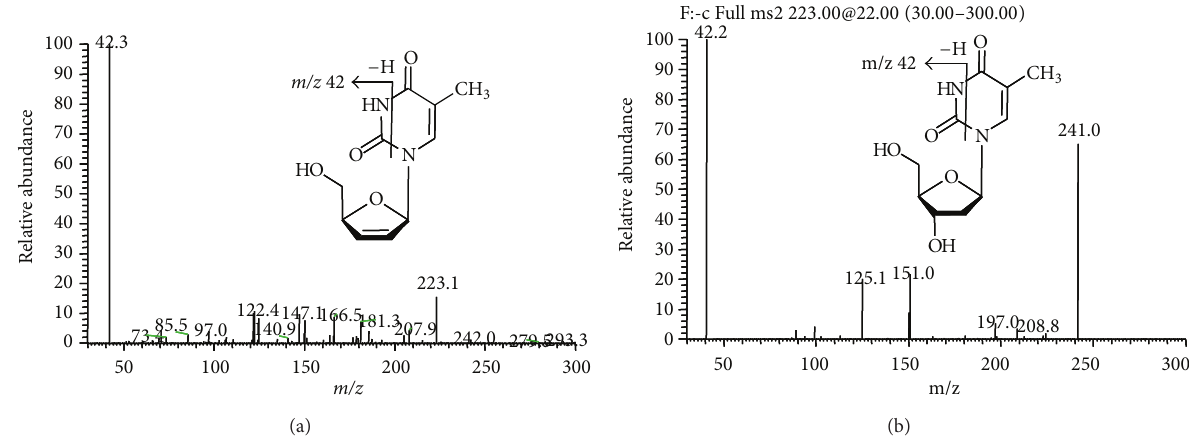
Figure 1: Full-scan product ion spectra of [M–H] − of (a) stavudine and (b) 𝛽 -thymidine (internal standard).